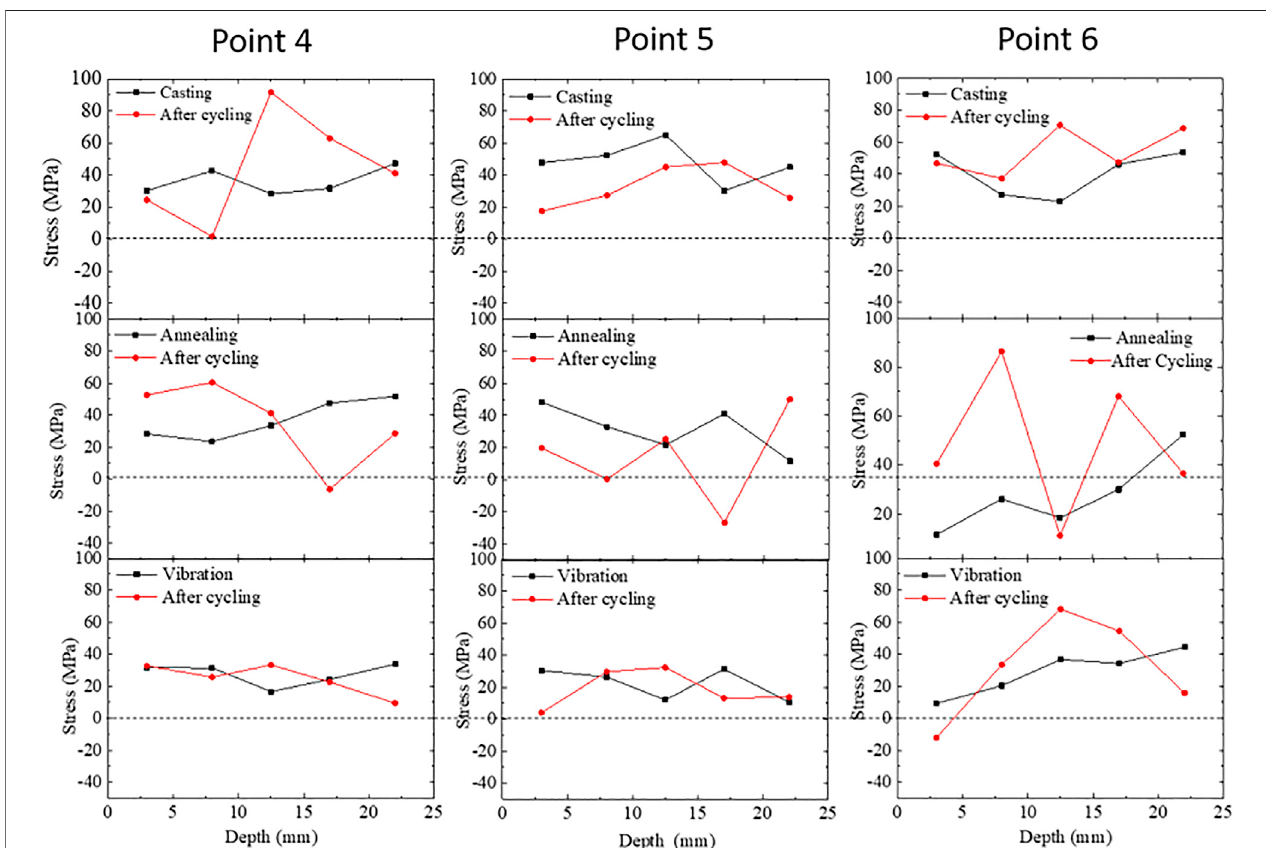
FIGURE 5 | Depth pro fi le analysis of the residual stress in the stress frame of the gray iron with the three conditions after cycling heating.